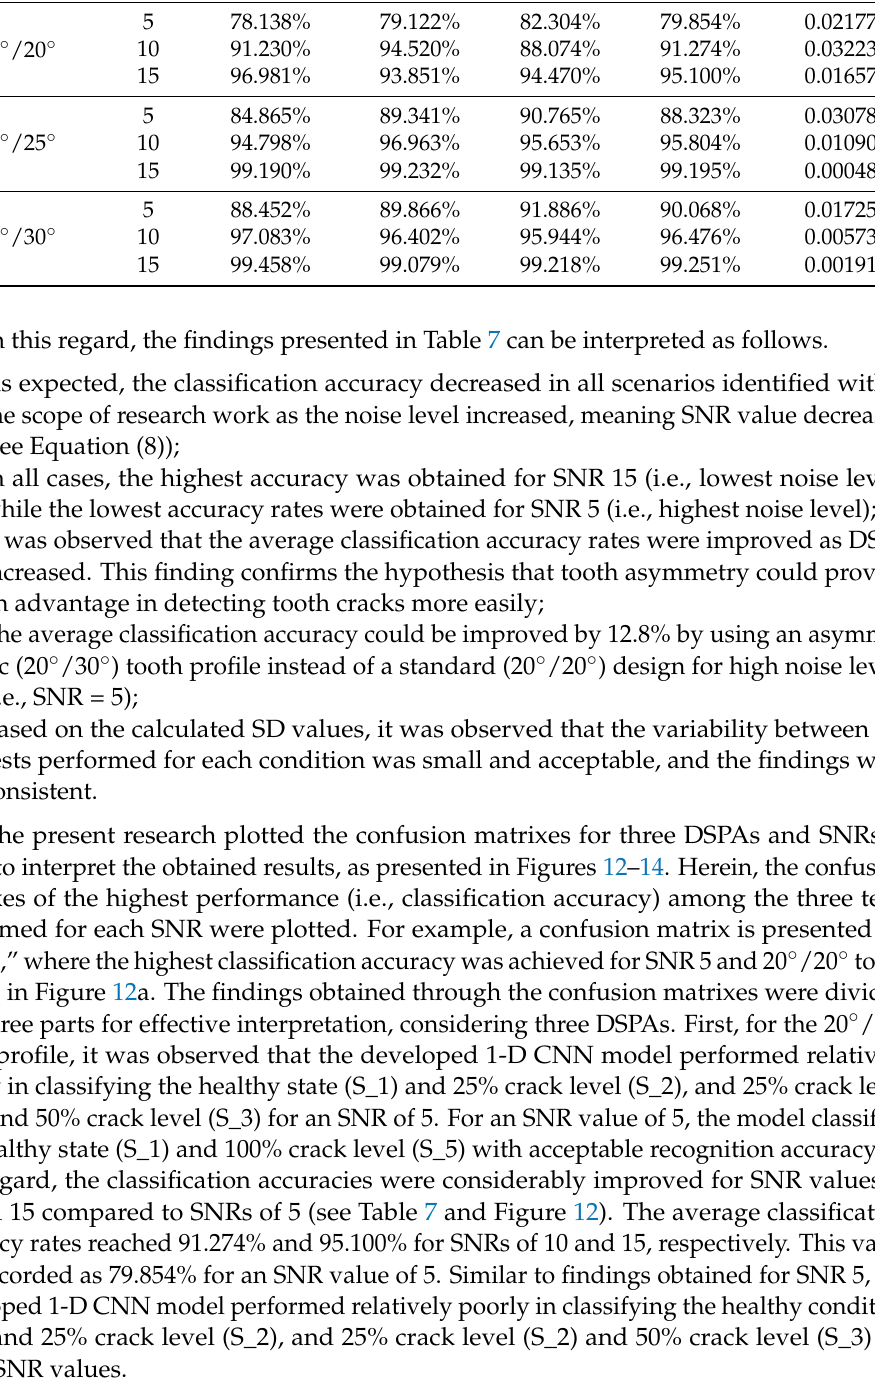
Table 7. Comparison of results obtained for all scenarios identified within the scope of the present study. Tooth Profile SNR Test-1